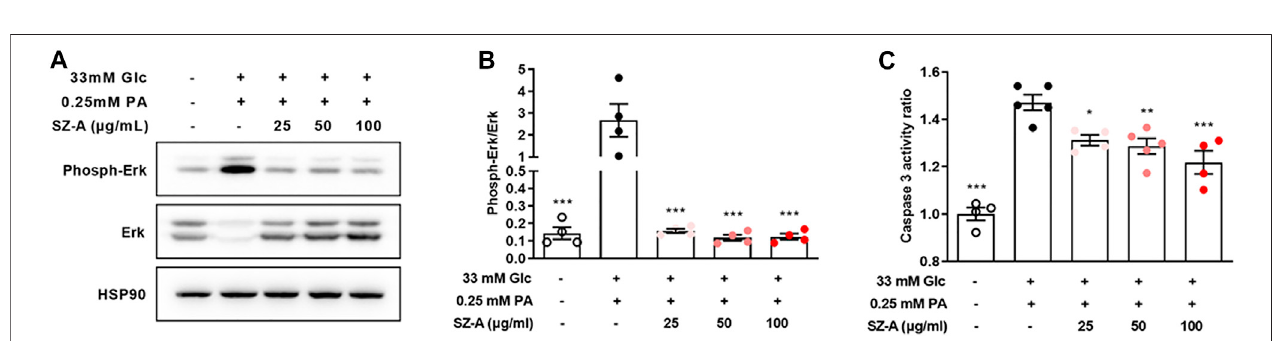
FIGURE5| SZ-A decreased Erk1/2 phosphorylationand caspase3 activity inhigh glucose- and PA-treated MIN6cells. MIN6cellswere treated withhigh glucose and PA and 25, 50, or 100 μ g/ml SZ-A or vehicle for 24 h. (A,B) Erk1/2 expression levels and Erk1/2 phosphorylation levels in MIN6 cells ( n = 4 replicates in each condition). (C) Caspase 3 activity ratio in MIN6 cells ( n = 4 – 5 replicates in each condition). * p < 0.05, ** p < 0.01, *** p < 0.001, vs. the Glc + PA